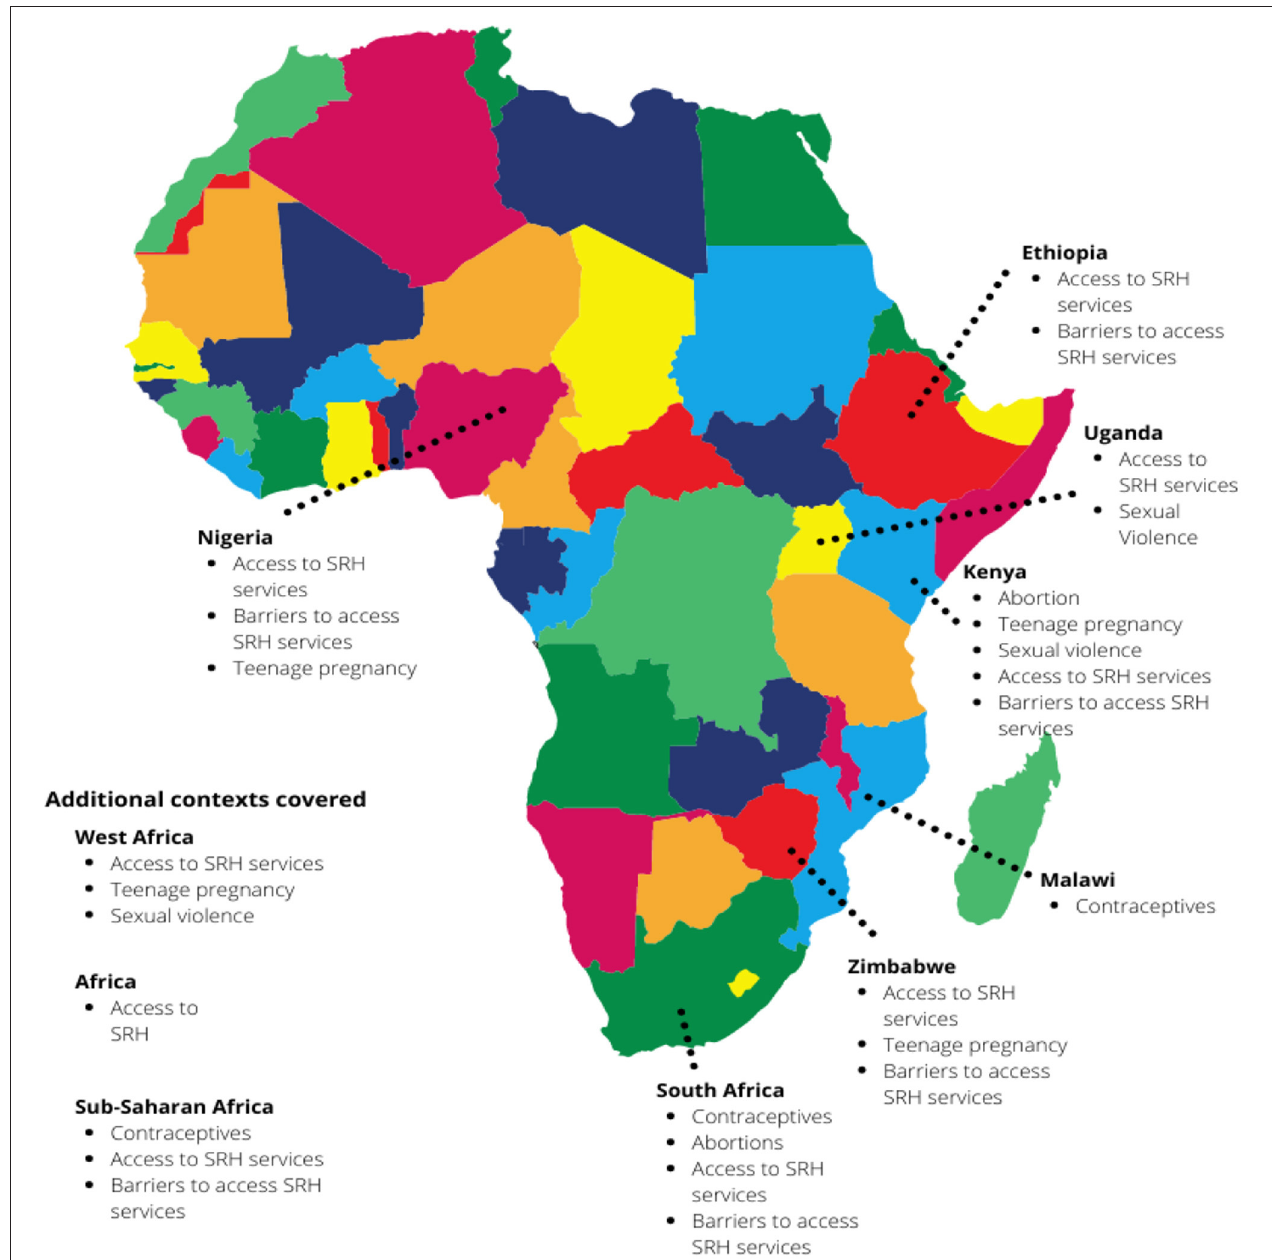
FIGURE 2 | Map of countries included in this mini